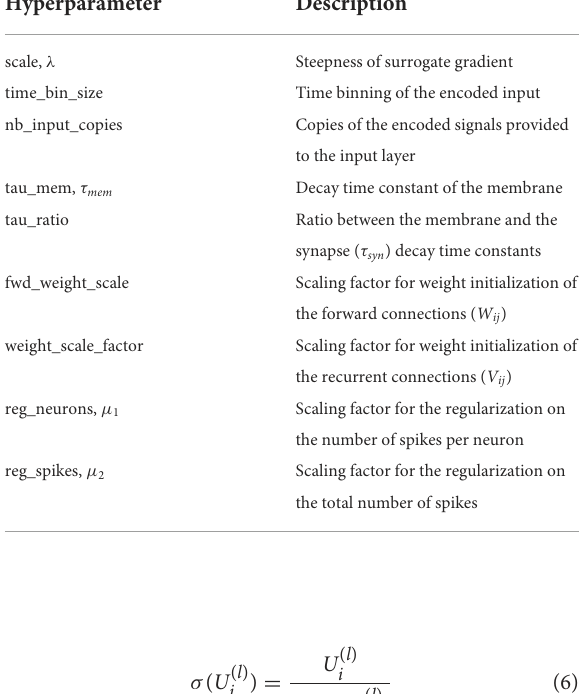
TABLE 1 Description of the hyperparameters included in the search space for the HPO procedure.